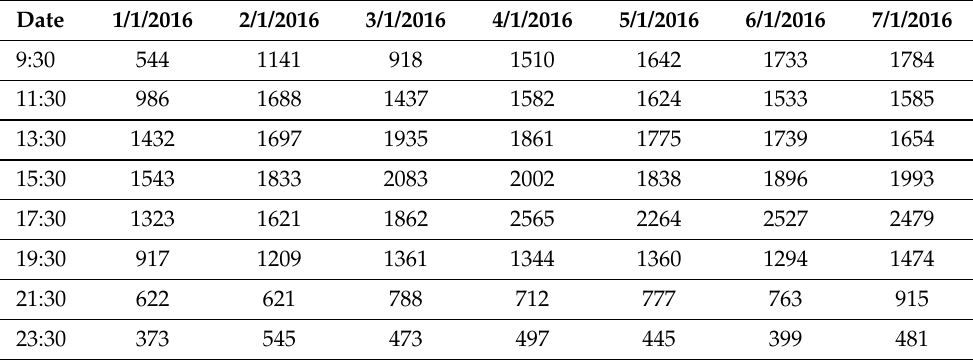
Table 1. An example of the traffic flow data set collected at the Dublin airport link road for different days of a week and different time periods of a